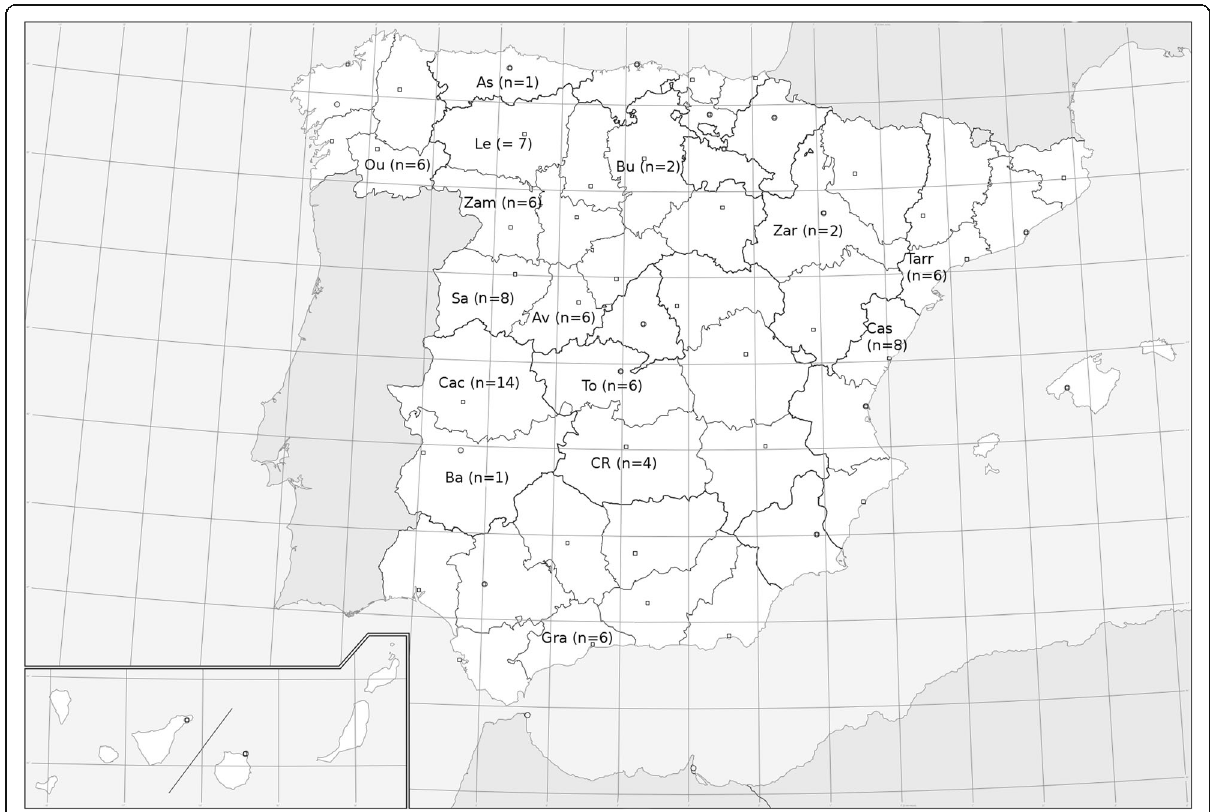
Fig. 1 Locations of Spain where the samples were collected. Asturias (As), Ávila (Av), Badajoz (Ba), Burgos (Bu), Cáceres (Cac), Castellón (Cas), Ciudad Real (CR), Granada (Gra), León (Le), Ourense (Ou), Salamanca (Sa), Tarragona (Tarr), Toledo (To), Zamora (Zam), and Zaragoza